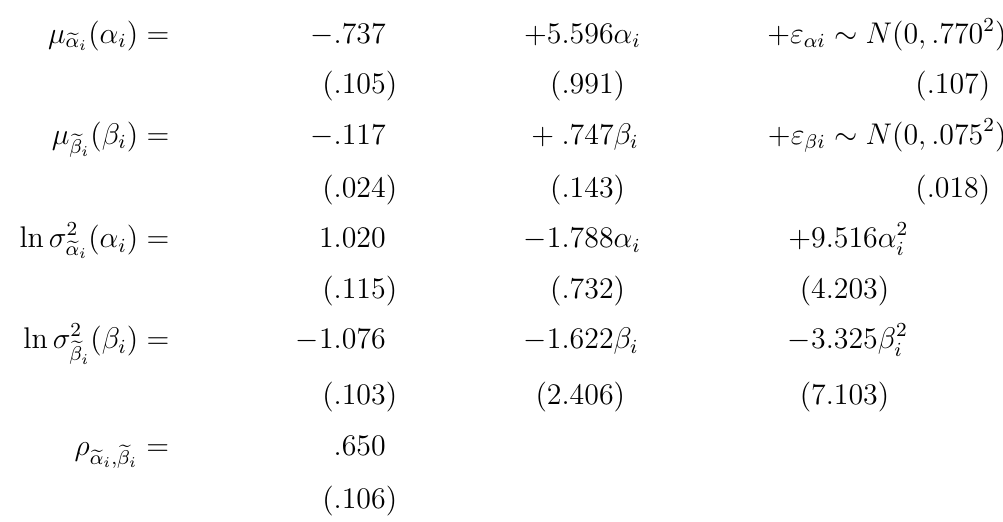
Figure 3. Expected other-regarding preferences versus own other-regarding preferences based on the posterior means of the parameters in Table 2. Grey shaded areas represent the relationship between expected variance (uncertainty) in others’ other-regarding preferences and own other-regarding preferences; i.e. , the boundaries of the grey areas are: µ ( 1 . 65 σ ( α ) and µ ( (cid:101) β ) ± 1 . 65 σ ( (cid:101) β ) . Note that ± 1 . 65 σ ( (cid:101) β ) refer to 90% confidence intervals. (cid:101) The solid lines within these areas represent the relationship between average expected other-regarding preferences and own other-regarding